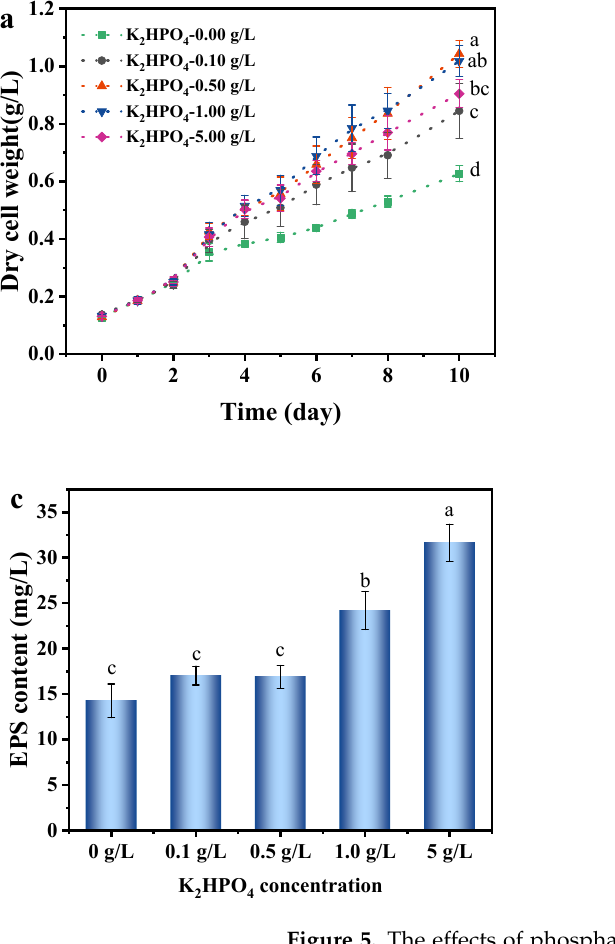
Figure 5. The effects of phosphate concentration on the growth and EPS secretion of A. platensis : ( a ) Growth curves; ( b ) Biomass production and growth rate; ( c ) EPS content; ( d ) EPS yield; DW: dry weight; a − d: Different letters above the bars indicated a significant difference among the groups. Points showed average of three independent measurements; vertical bars indicated the standard deviation. ( p < 0.01, n = 3).